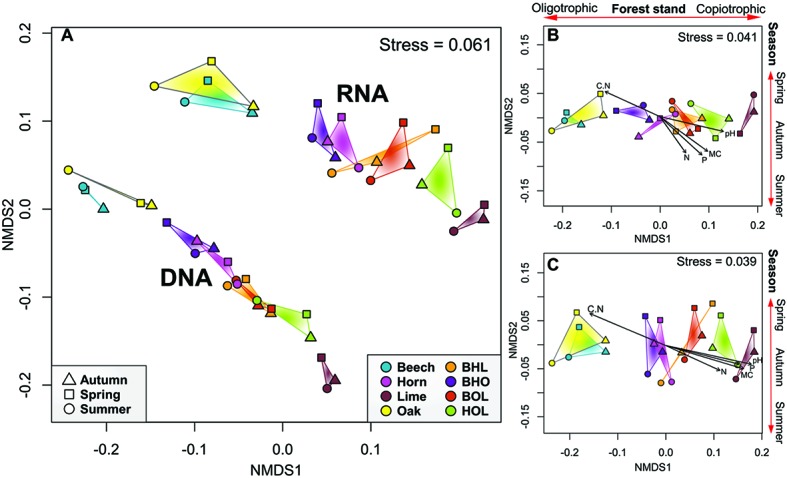
Non-metric multidimensional scaling (NMDS) analysis of soil bacterial communities in mono and mixed stands. (A) NMDS plot for total and active community. (B,C) NMDS plots for total and active community, respectively, showing the goodness of fit for soil environmental parameters. Ordination employed weighted UniFrac distance matrices of OTUs. Samples are grouped according to season, whereby each data point represents the summarized taxonomic data of six replicate stands. Arrows outside the plot area have no statistical significance and are only a visual aid of observed trends. C/N ratio (C/N), phosphorus content (P), nitrogen content (N), soil moisture (MC), operational taxonomic unit (OTU).